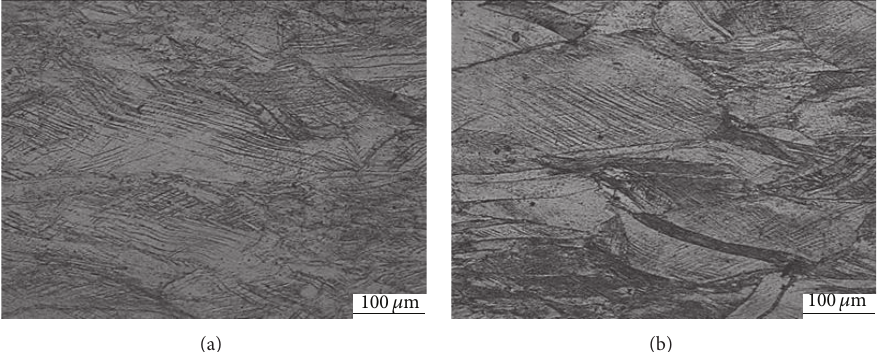
Figure 7: (a, b) Microstructure of the 70 𝜇 m Cu-4.7Al and Cu-7Al deformed to true axial strains of 0.5 in plane strain compression on the transverse section,